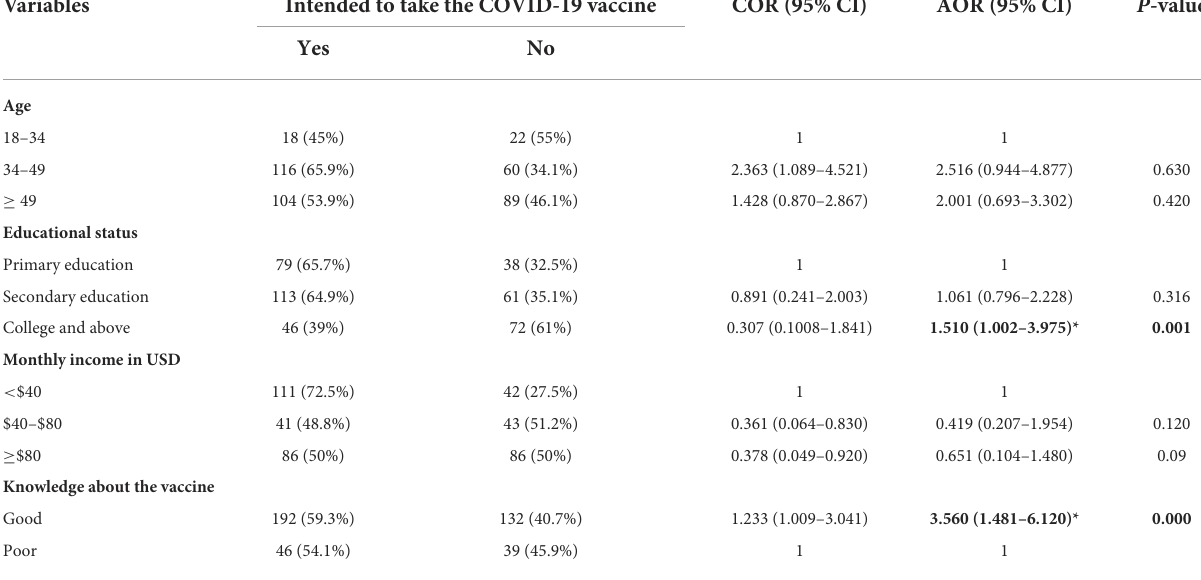
TABLE 4 Factors associated with intention to take COVID-19 vaccine among patients with chronic diseases, southern Ethiopia, 2021 ( N = 409).